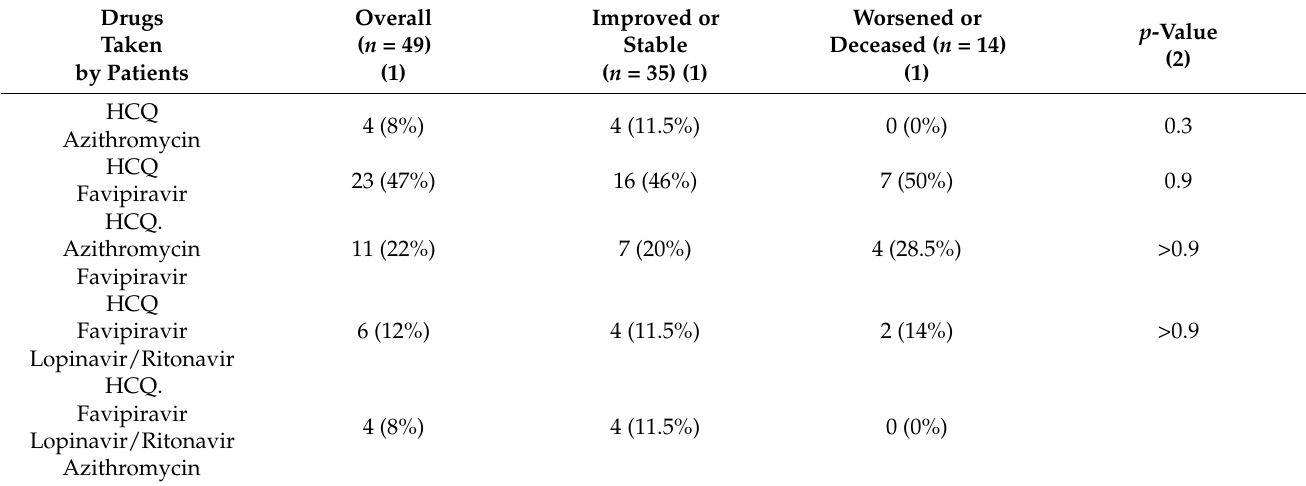
Table 2. Drugs taken by the study